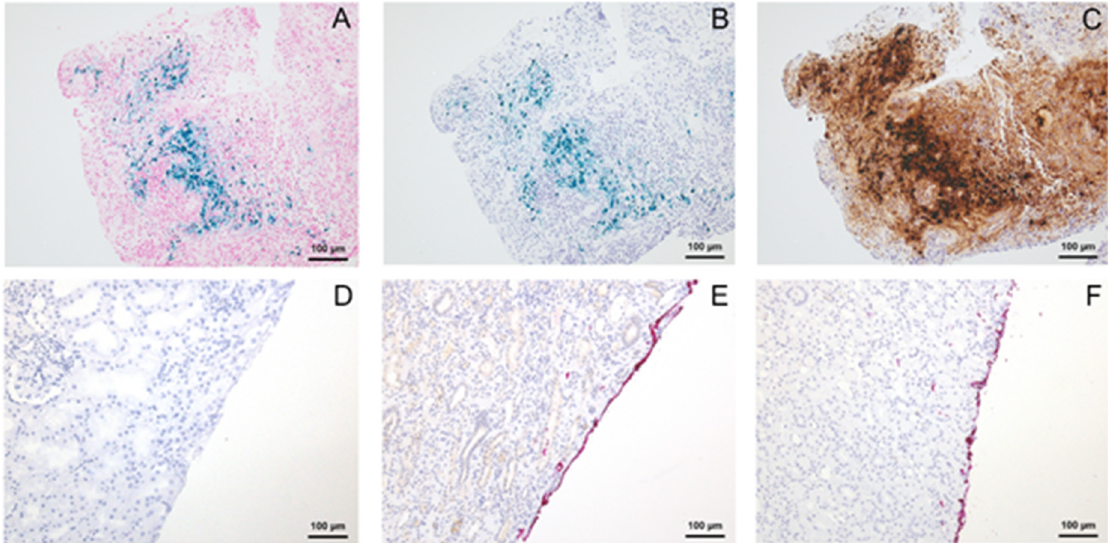
Figure 2. Tissue specimens of haemorrhagic endometriosis using the Perls’ reaction ( A ), Kit A ( B ) or Kit B ( C ). Vanishing of red colour from provider A ( D ) and intensity of red colour from providers B ( E ) and C ( F ) after immunohistochemistry in kidney tissue.